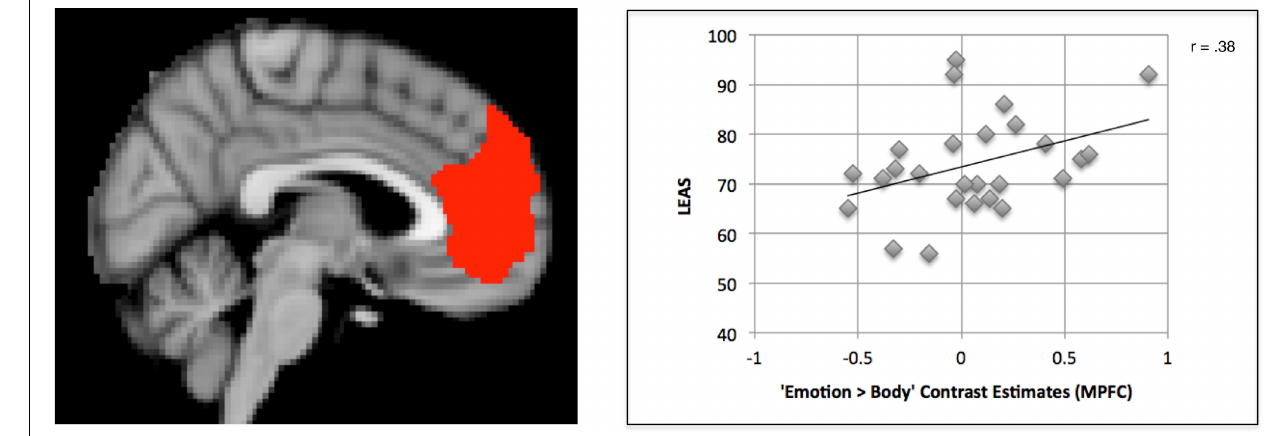
FIGURE 2 | Illustration of the positive correlation observed between MPFC activation for the “Emotion > Body” contrast and LEAS scores. The MPFC ROI used is shown on the left. A scatterplot of the data is shown on the right, which illustrates the positive relationship observed.